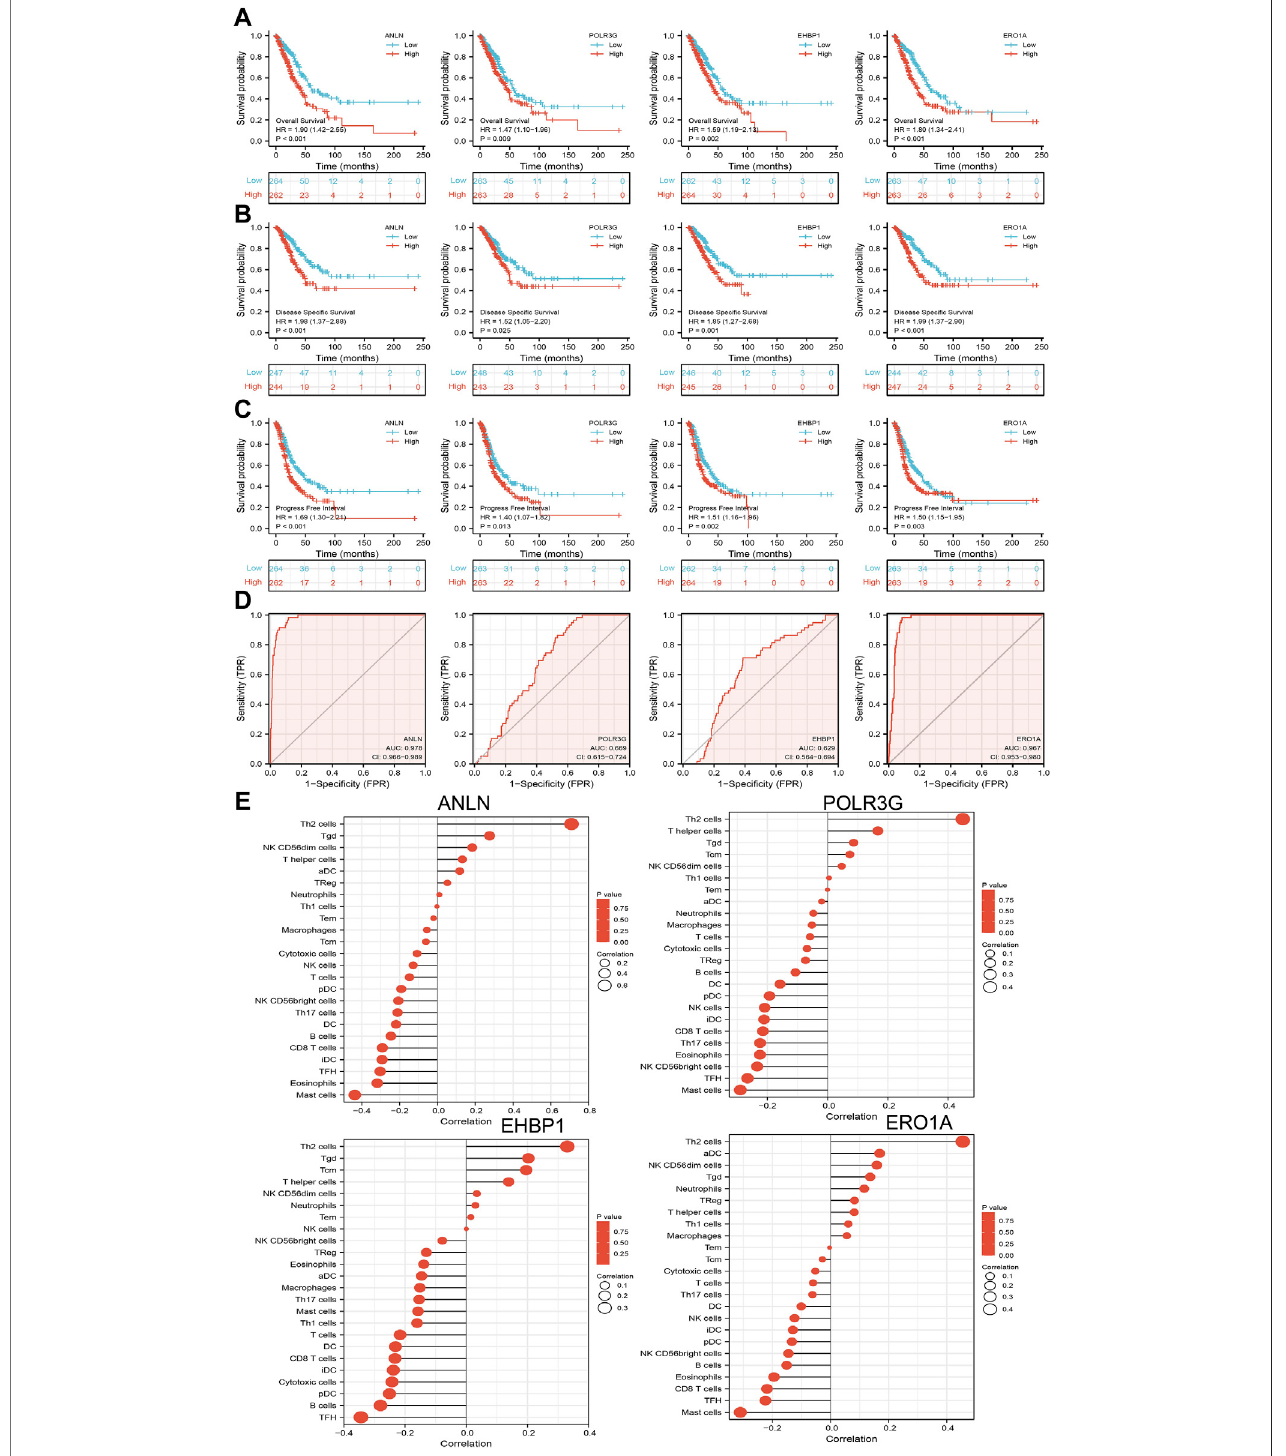
FIGURE 10 | Analysis of the prognostic and diagnostic value of ANLN, POLR3G, EHBP1, and ERO1A in LUAD. (A – C) OS, DSS, and PFS of ANLN, POLR3G, EHBP1, and ERO1A in LUAD. (D) ROC curve of ANLN, POLR3G, EHBP1, and ERO1A in LUAD. (E) Correlation between ANLN, POLR3G, EHBP1, and ERO1A expression and immune in fi ltration levels of 24 immune cells in LUAD.